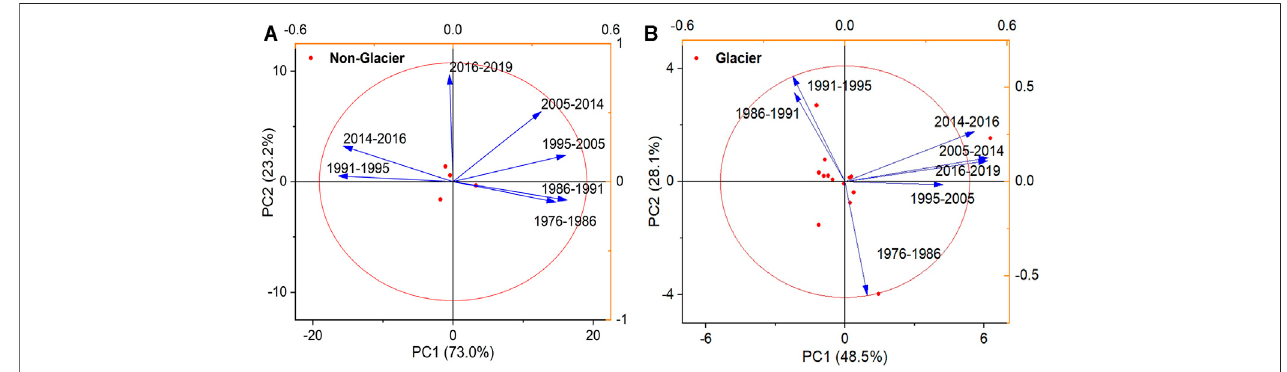
FIGURE 8 | (A) PCA analysis results for AAVCR_B with glacier meltwater supplied lakes; (B) PCA analysis results for AAVCR_B with non-glacier meltwater replenished lakes.